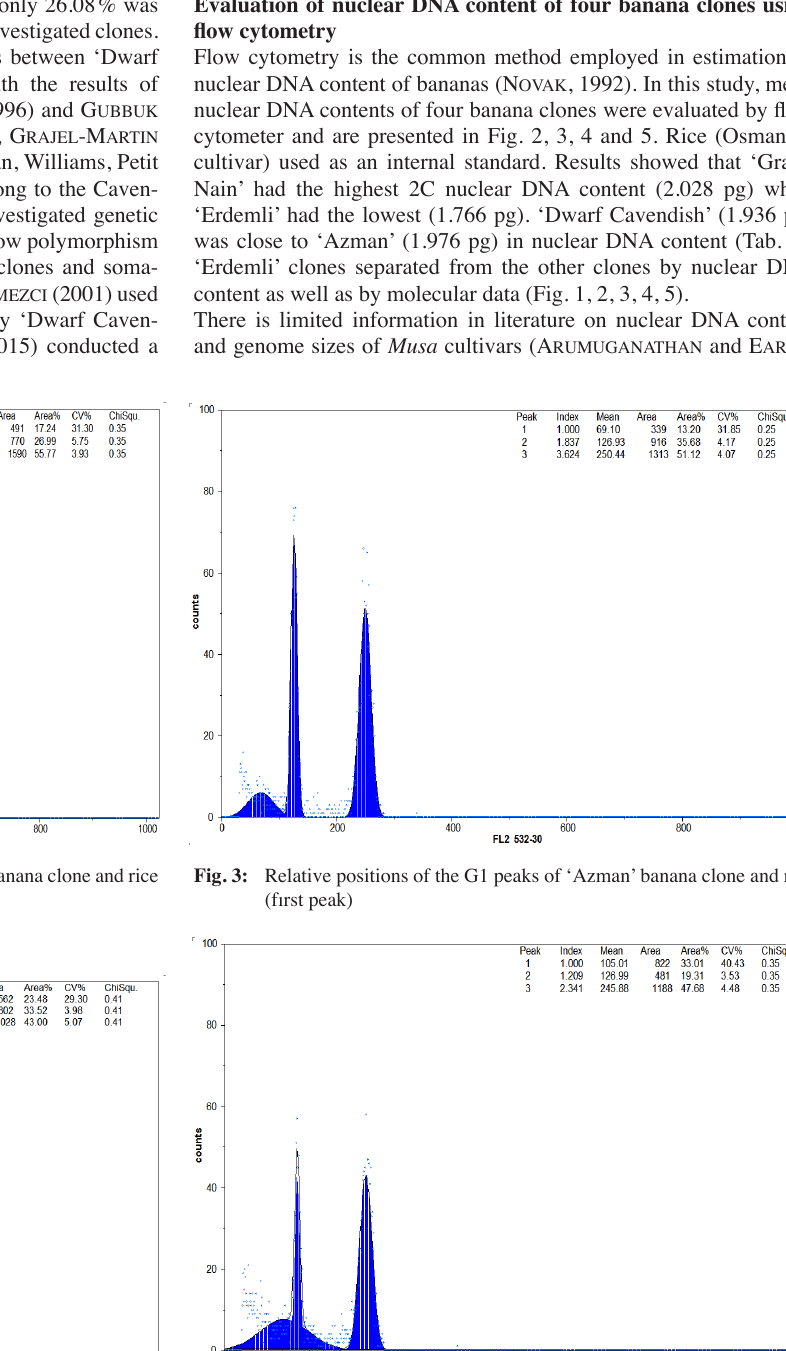
Fig. 5: Relative positions of the G1 peaks of ‘Dwarf Cavendish’ banana cultivar and rice (fırst peak)